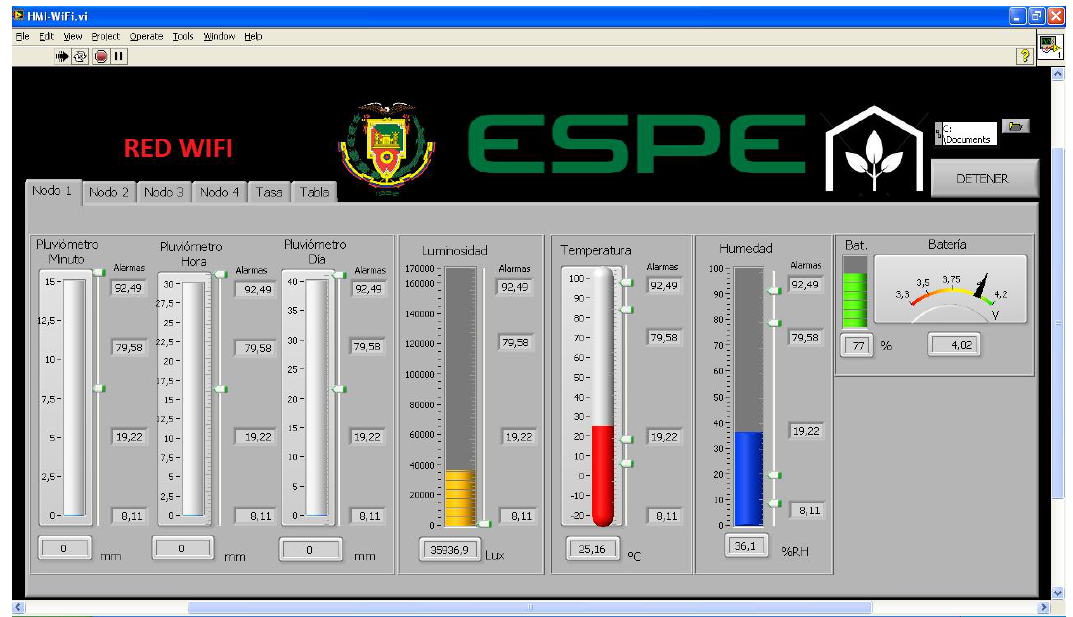
Figure 5. Monitoring of greenhouse variables, battery condition, alarms, data rate, and table for the WiFi